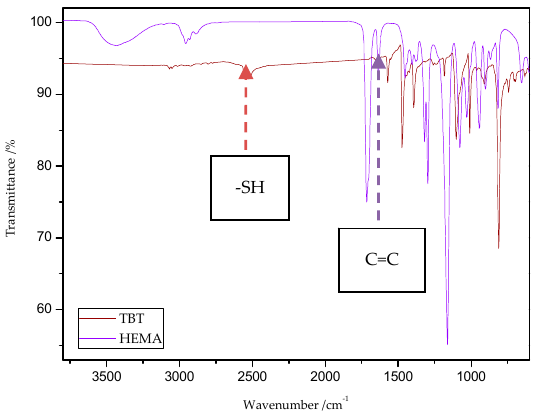
Figure 16. ATR / FT-IR spectra of 4,4 (cid:48) -thiobisbenzenethiol (TBT) and 2-hydroxyethyl methacrylate (HEMA). Figure 16. ATR/FT-IR spectra of 4,4 ′ -thiobisbenzenethiol (TBT) and 2-hydroxyethyl methacrylate (HEMA).